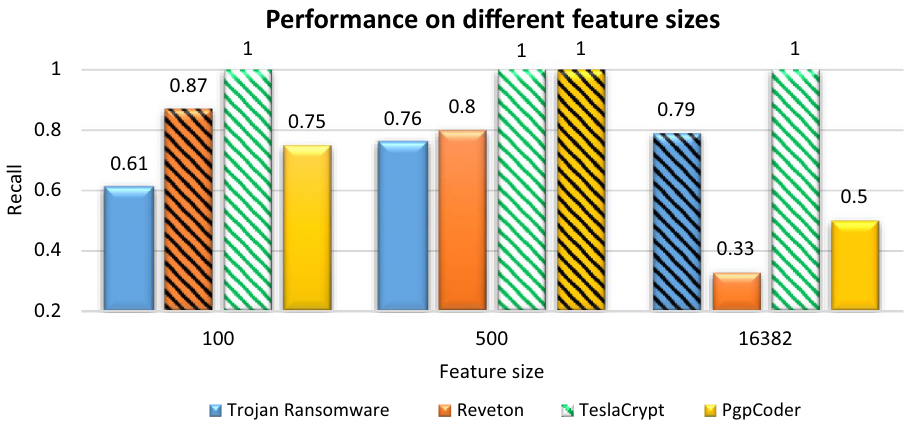
Figure 9. Comparison of different feature subspaces against zero-day test data.